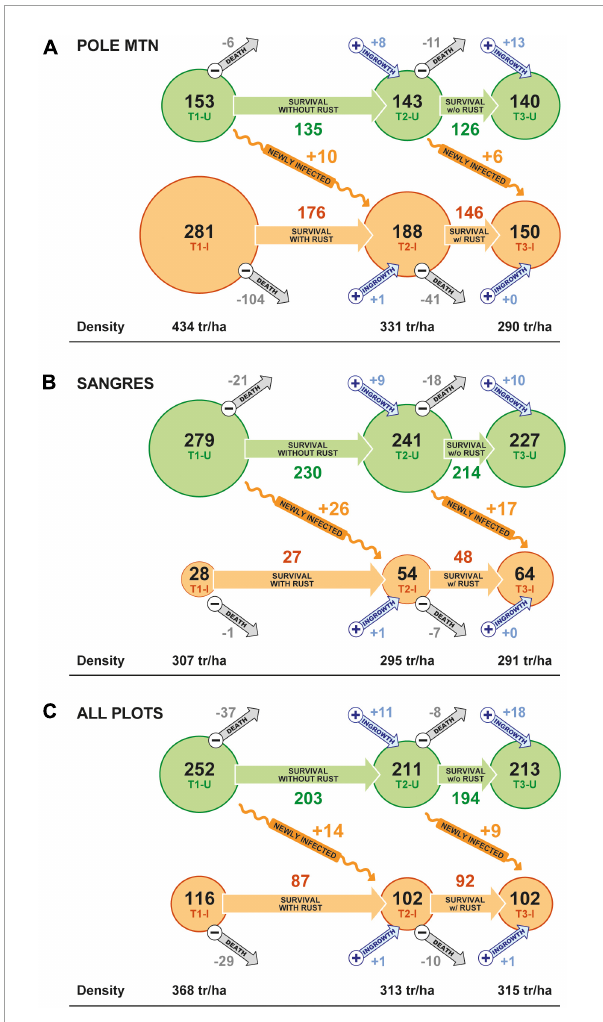
FIGURE5 Changes in stand density (trees ha − 1 ) across the three measurement periods (T1, T2, and T3) of disease-free (green circles) and diseased (orange circles) limber pine trees greater than 1.37 m tall in the (A) Pole Mountain area, (B) Sangres area, and (C) for all plots combined. Pole Mountain is an example of where WPBR is well established, and the Sangre de Cristo area is one that has only recently been invaded by C. ribicola . Within each panel, gray arrows depict density loss to mortality (all causes) and blue arrows indicate ingrowth of new trees into the > 1.37 m height class. The horizontal distance between T1, T2, and T3 circles generally reflects time between measurement periods. The orange squiggly arrows show the density of trees that transitioned from disease-free to diseased between the two time periods. Average tree density has been rounded to the nearest individual per hectare to simplify the